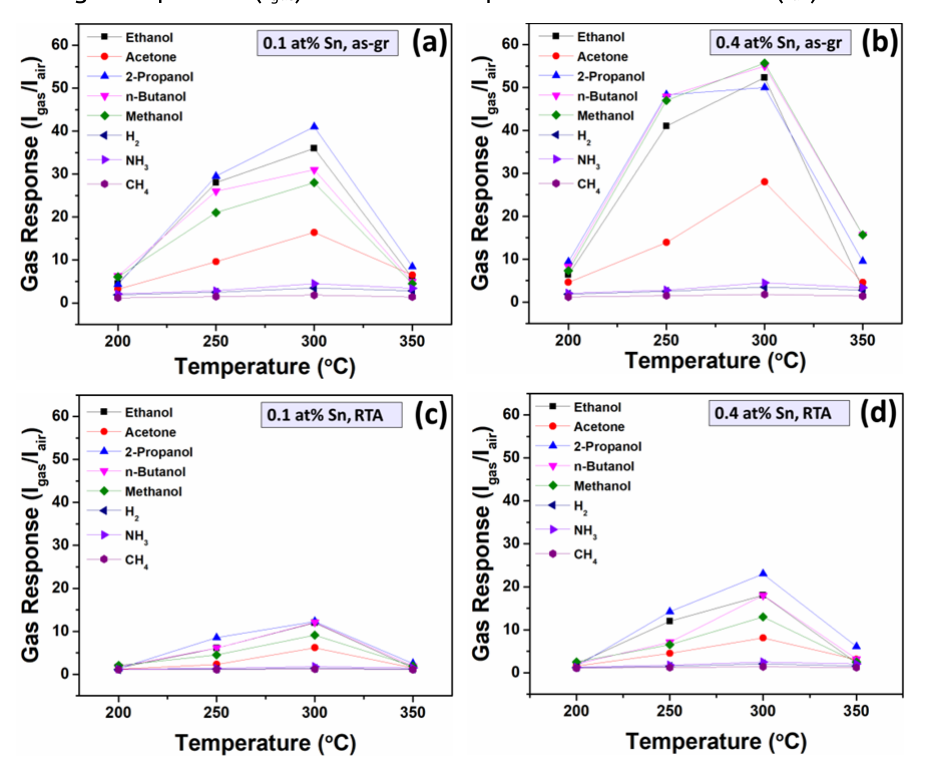
Figure 1. The gas response versus operating temperature for ZnO:Sn nanostructured films: (a) 0.1 at% Sn, as-grown; (b) 0.4 at% Sn, as-grown; (c) 0.1 at% Sn, RTA at 725 ºC; (d) 0.4 at% Sn, RTA at 725